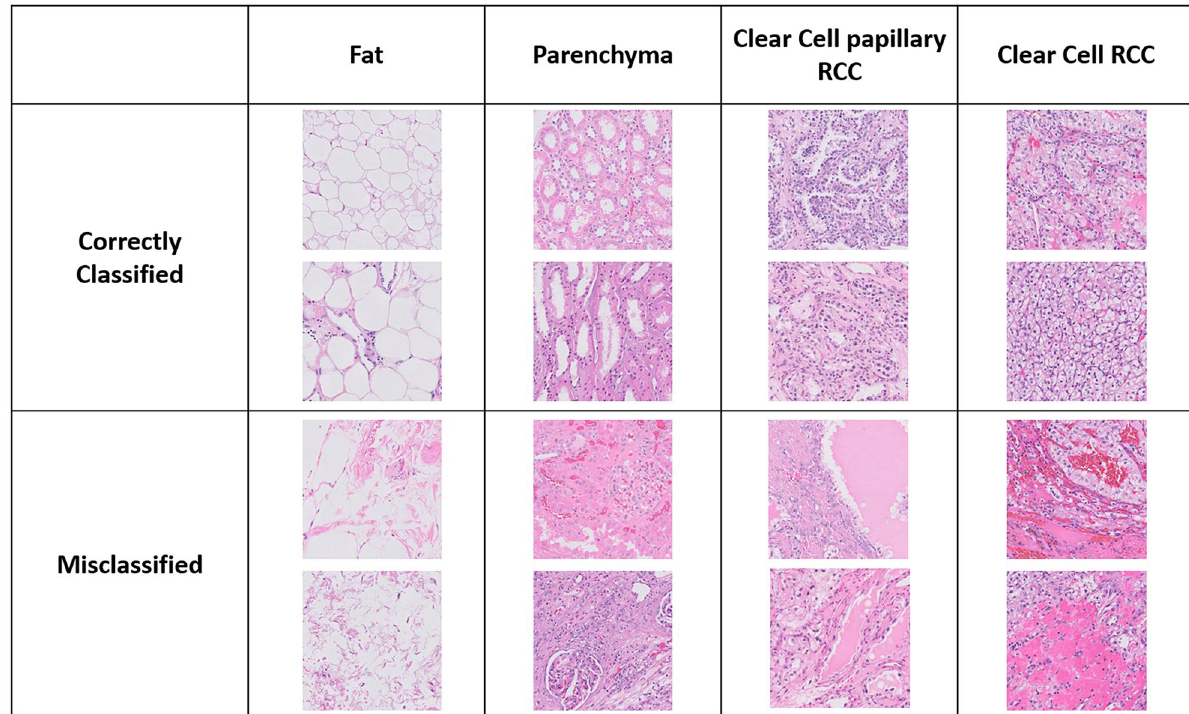
Figure 5. Samples of correctly and wrongly classified patches for the